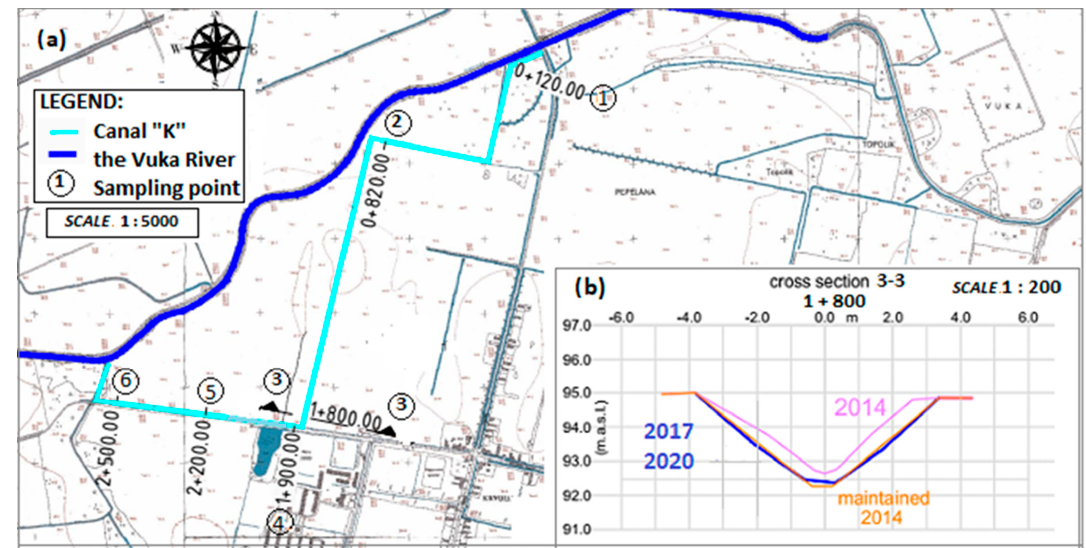
Figure 2. Field research layout of canal with designated sampling locations ( a ) and characteristic cross-section of canal indicating profile reduction ( b ).